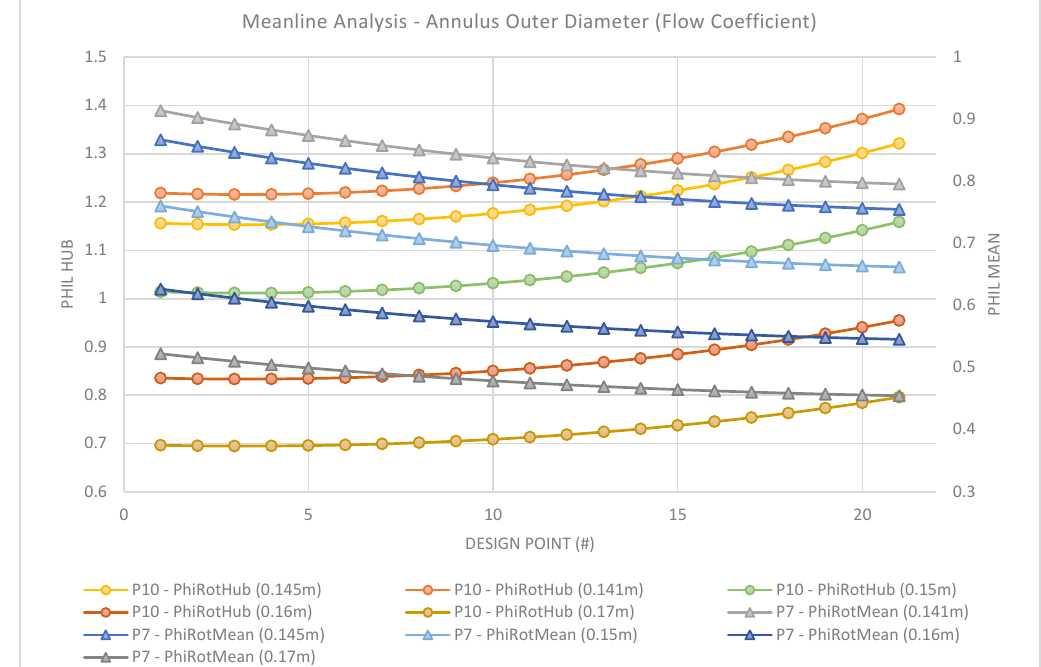
Figure 14. Meanline analysis—annulus outer diameter (flow coefficient). Table 7. Iteration procedure for the meanline analysis of the annulus outer diameter 0.17 m.